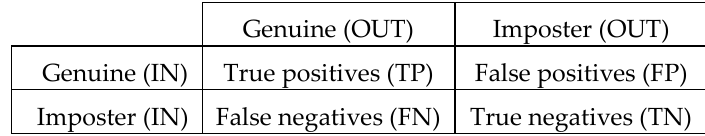
Figure 9. Confusion matrix in a verification stage and definition of each variable.